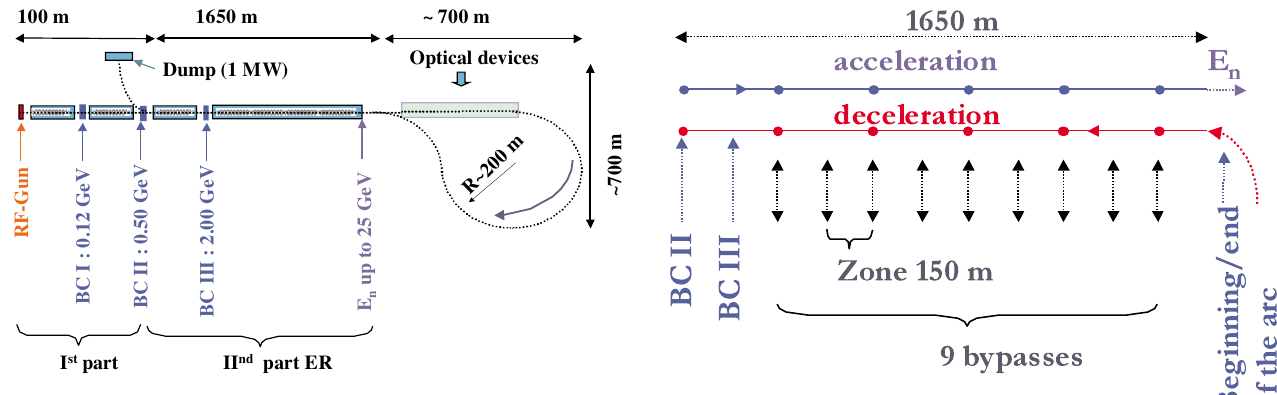
FIG. 7. (Color) Preliminary layout of the facility based on the single return